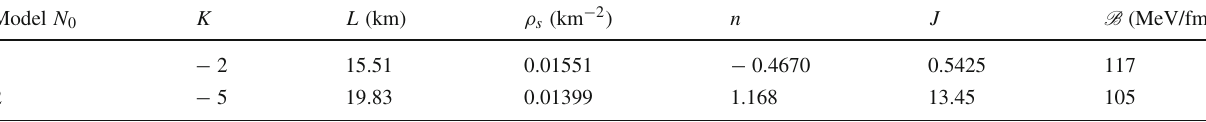
Table 1 Model parameters of initial unstable static configuration ( M = 2 . 015 M (cid:5) ; R = 9 . 384 km ) Model N